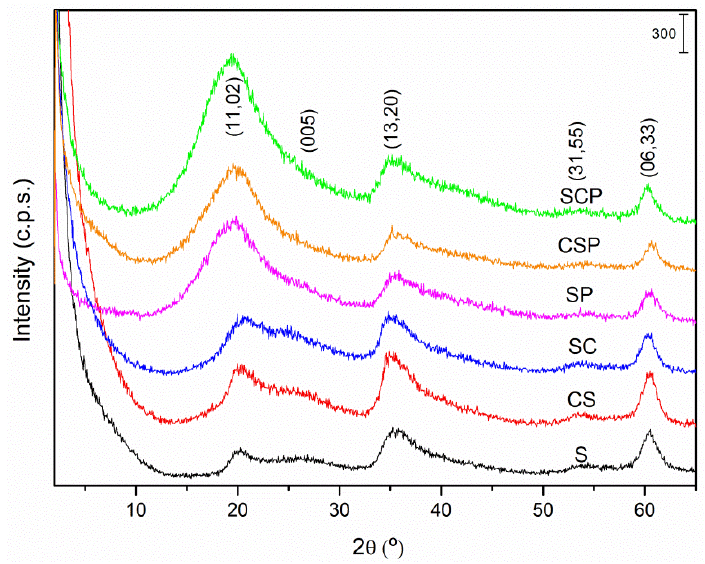
Figure 1. X-ray diffractograms of the saponite (S) the organosaponites (SC and CS) and the PCM nanocomposites.